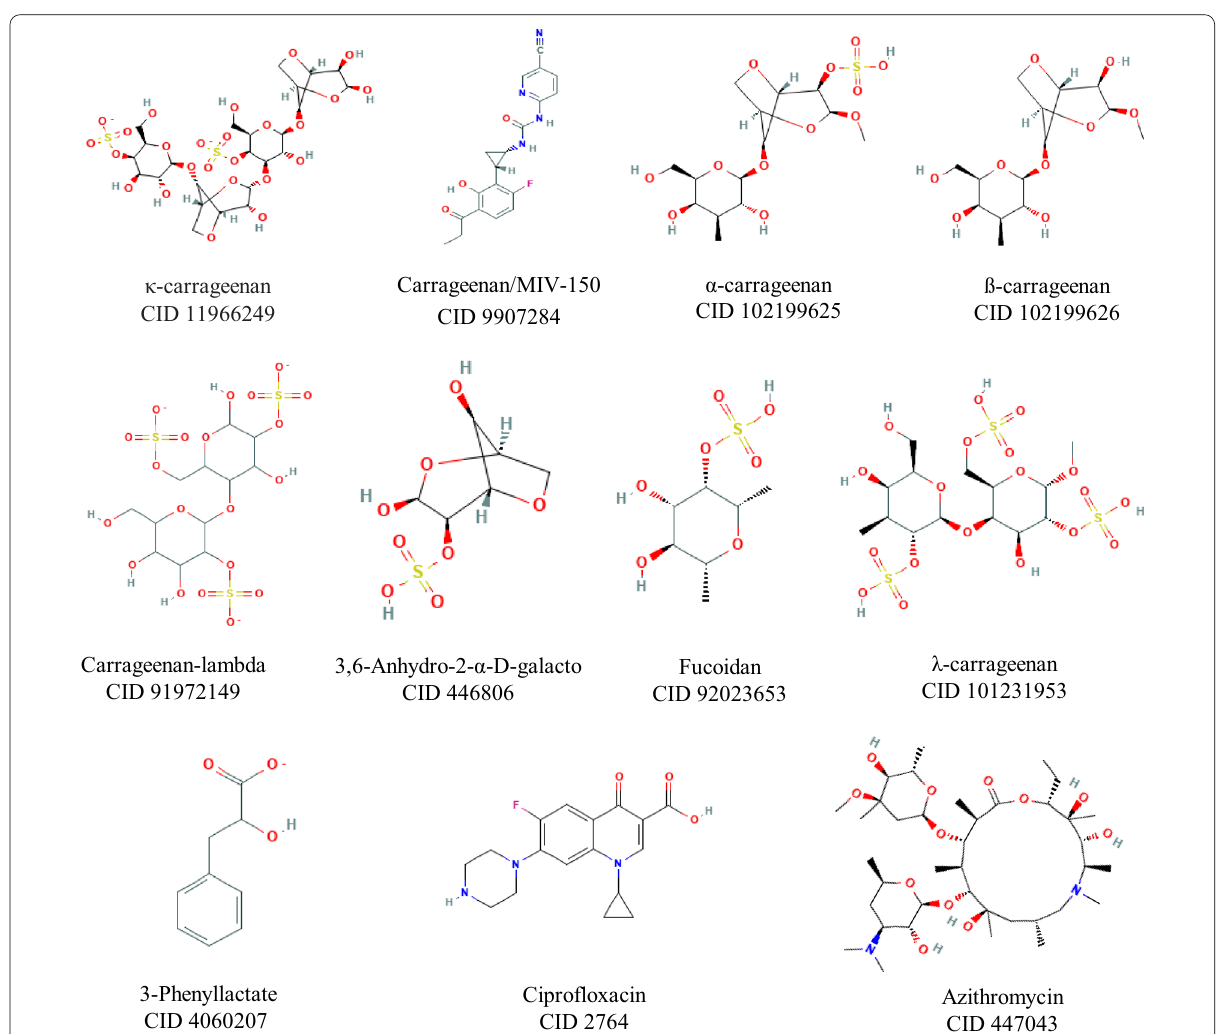
Fig. 1 Two-dimensional chemical structure of selected compounds (ligands) retrieved from PubChem database with compound